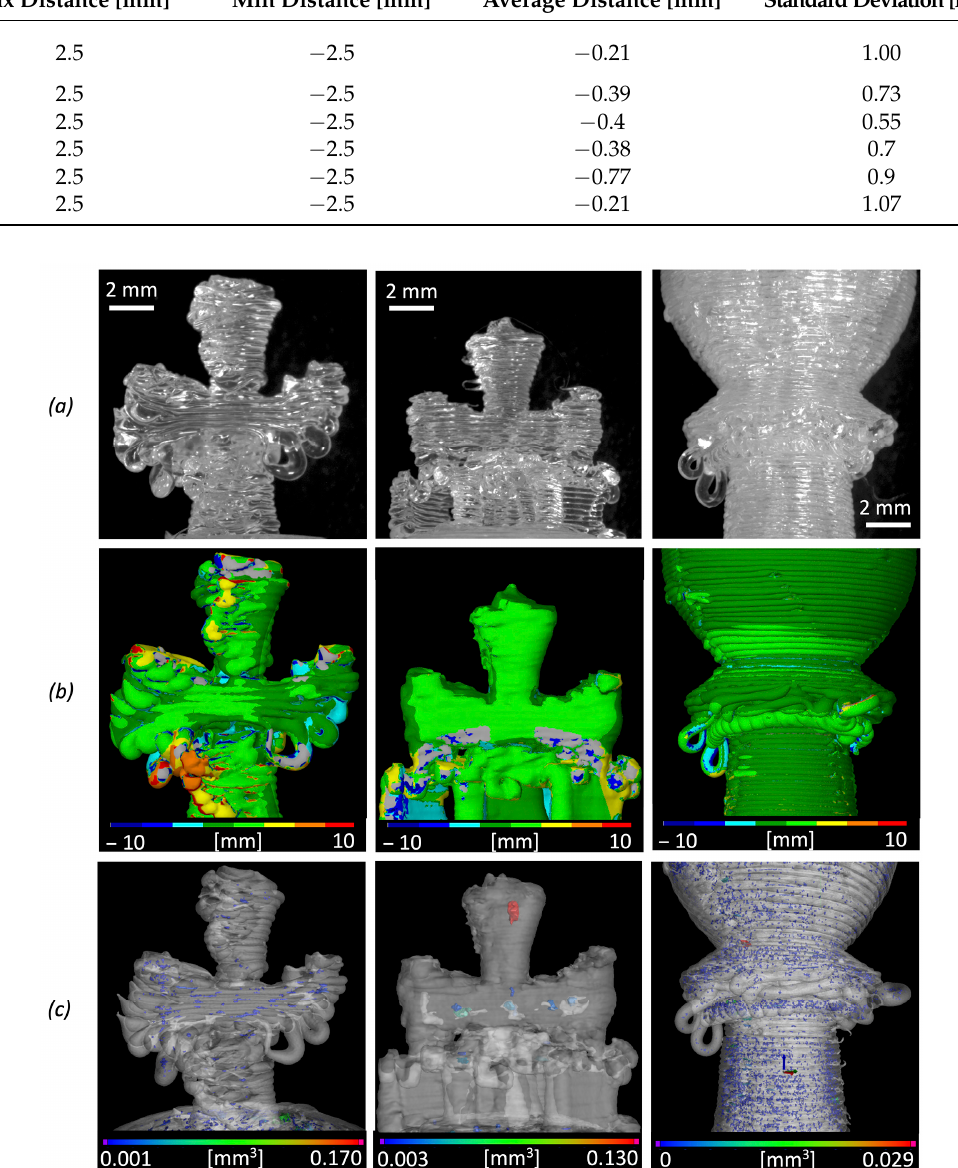
Figure 9. Representation of local defects for different chess pieces produced by FGF: cross detail of the king without support, cross detail of the king with supports and collar detail of the pawn without support. ( a ) Optical microscopy images; ( b ) GOM Inspect analysis results; ( c ) volume distributions of internal microporosities obtained by X-ray CT